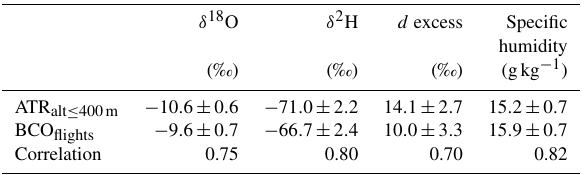
Table 10. Mean values and standard deviations over all flights for the measurements made by the Picarro onboard the ATR and at the BCO during the ATR flights, as well as the Pearson correlation be- tween the two datasets. δ 18 O δ 2